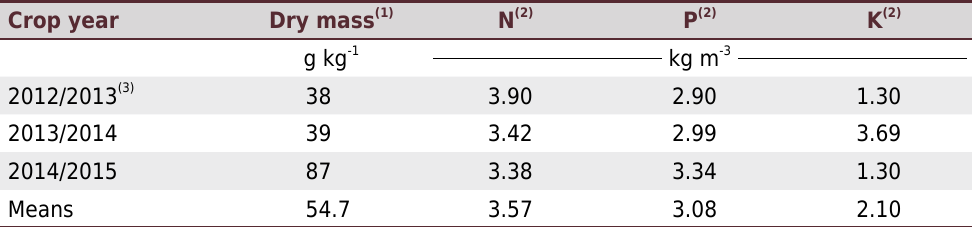
(1) Values determined by the weight difference between the wet swine manure and swine manure oven-dried at 65°C until a constant mass. (2) Contents determined after sulphuric digestion (Tedesco et al., 1995). (3) Data from Alves et al.